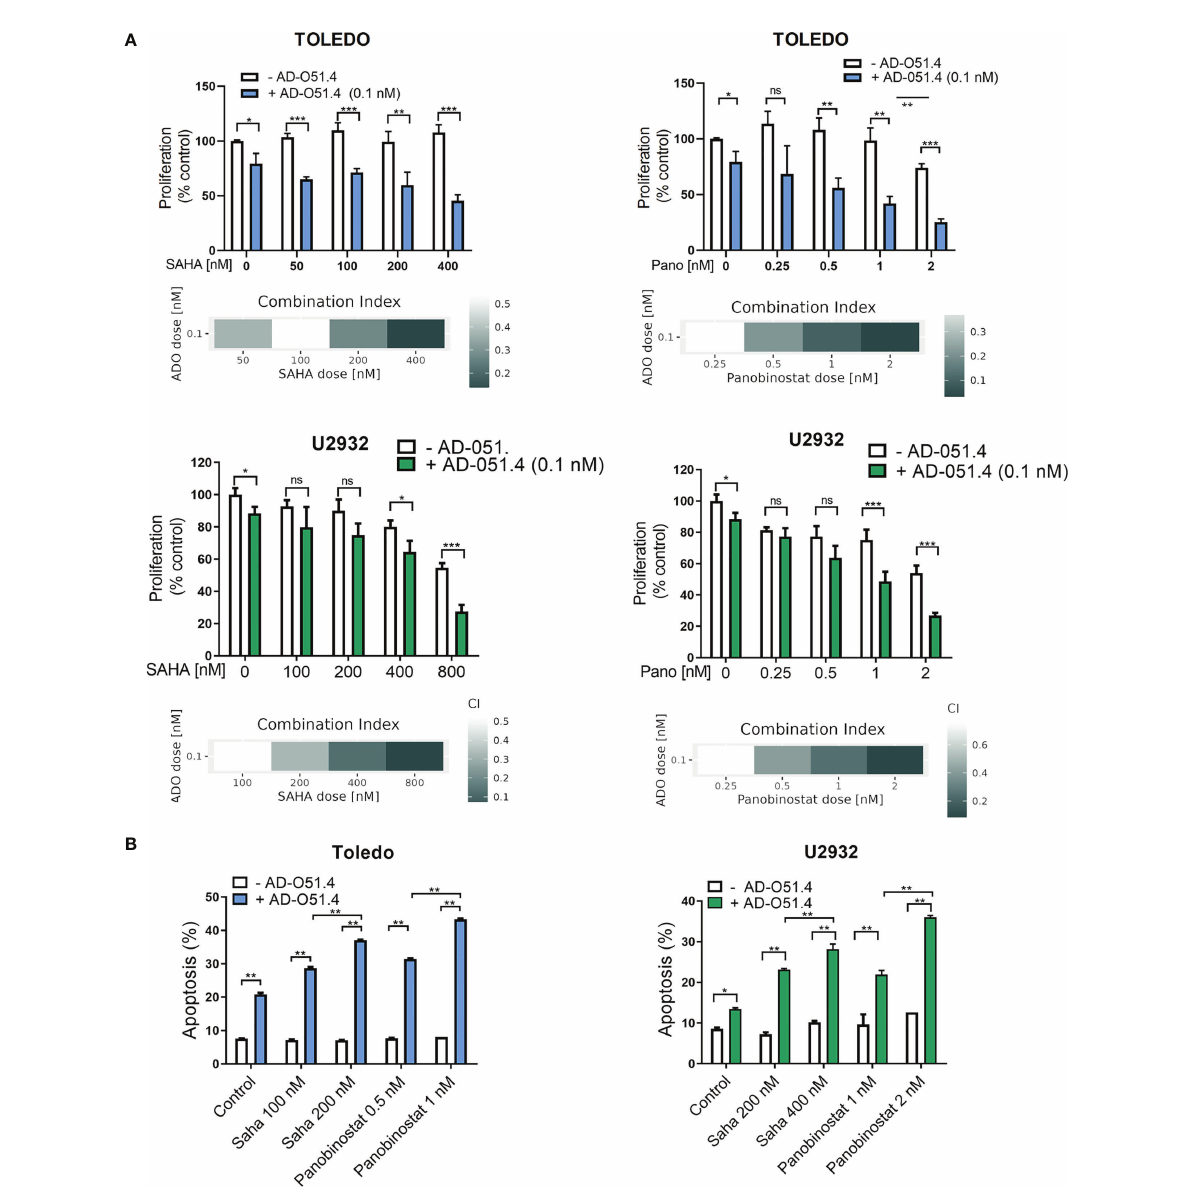
FIGURE 7 HDAC inhibitors sensitize resistant DLBCL cells to AD-O51.4. (A) Primary resistant TOLEDO and U2932 were preincubated with HDAC inhibitors SAHA (100 to 800 nM) or panobinostat (0.25 to 2 nM) or DMSO (control) for 24 h. Thereafter, cells were treated with 0.1 nM AD-O51.4 or PBS for additional 48 h. Cell viability was assessed using an MTS assay in triplicates. Bars and error bars indicate averages and standard deviations, respectively. Results were normalized to untreated cells (control). Combination indexes (CI) for all dose combinations are indicated below the plots. (B) Cells were treated as in A for 24h, and apoptosis was determined using Annexin V/PI staining. Bars indicate the average of the combined fraction of early and late apoptotic cells (PI-/AnnexinV+ and PI+/AnnexinV+, respectively) from two replicates. Error bars indicate standard deviations. In panels A-B, statistical differences were evaluated by t -test; *p-value<0.05, **p-value<0.005, ***p-value<0.001, ns – not signi fi